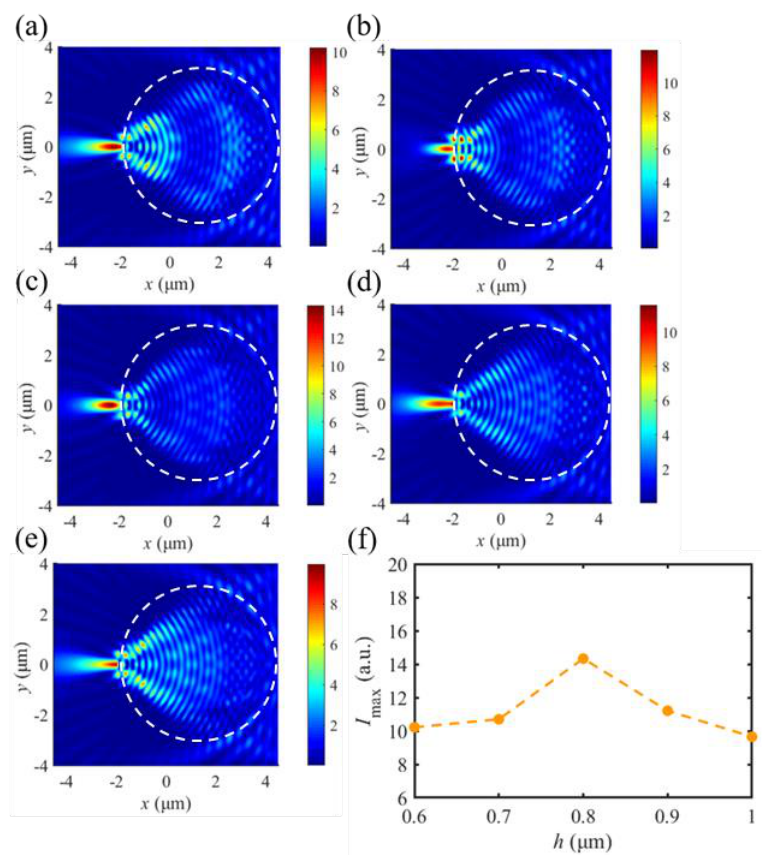
Figure 7. Optical field intensity evolution of the SPP-PNJ formed by different thicknesses of the dielectric microdisk: ( a ) h = 0.6 µ m, ( b ) h = 0.7 µ m, ( c ) h = 0.8 µ m, ( d ) h = 0.9 µ m, ( e ) h = 1.0 µ m, and ( f ) the maximum intensity I max evolution with different thicknesses of the dielectric